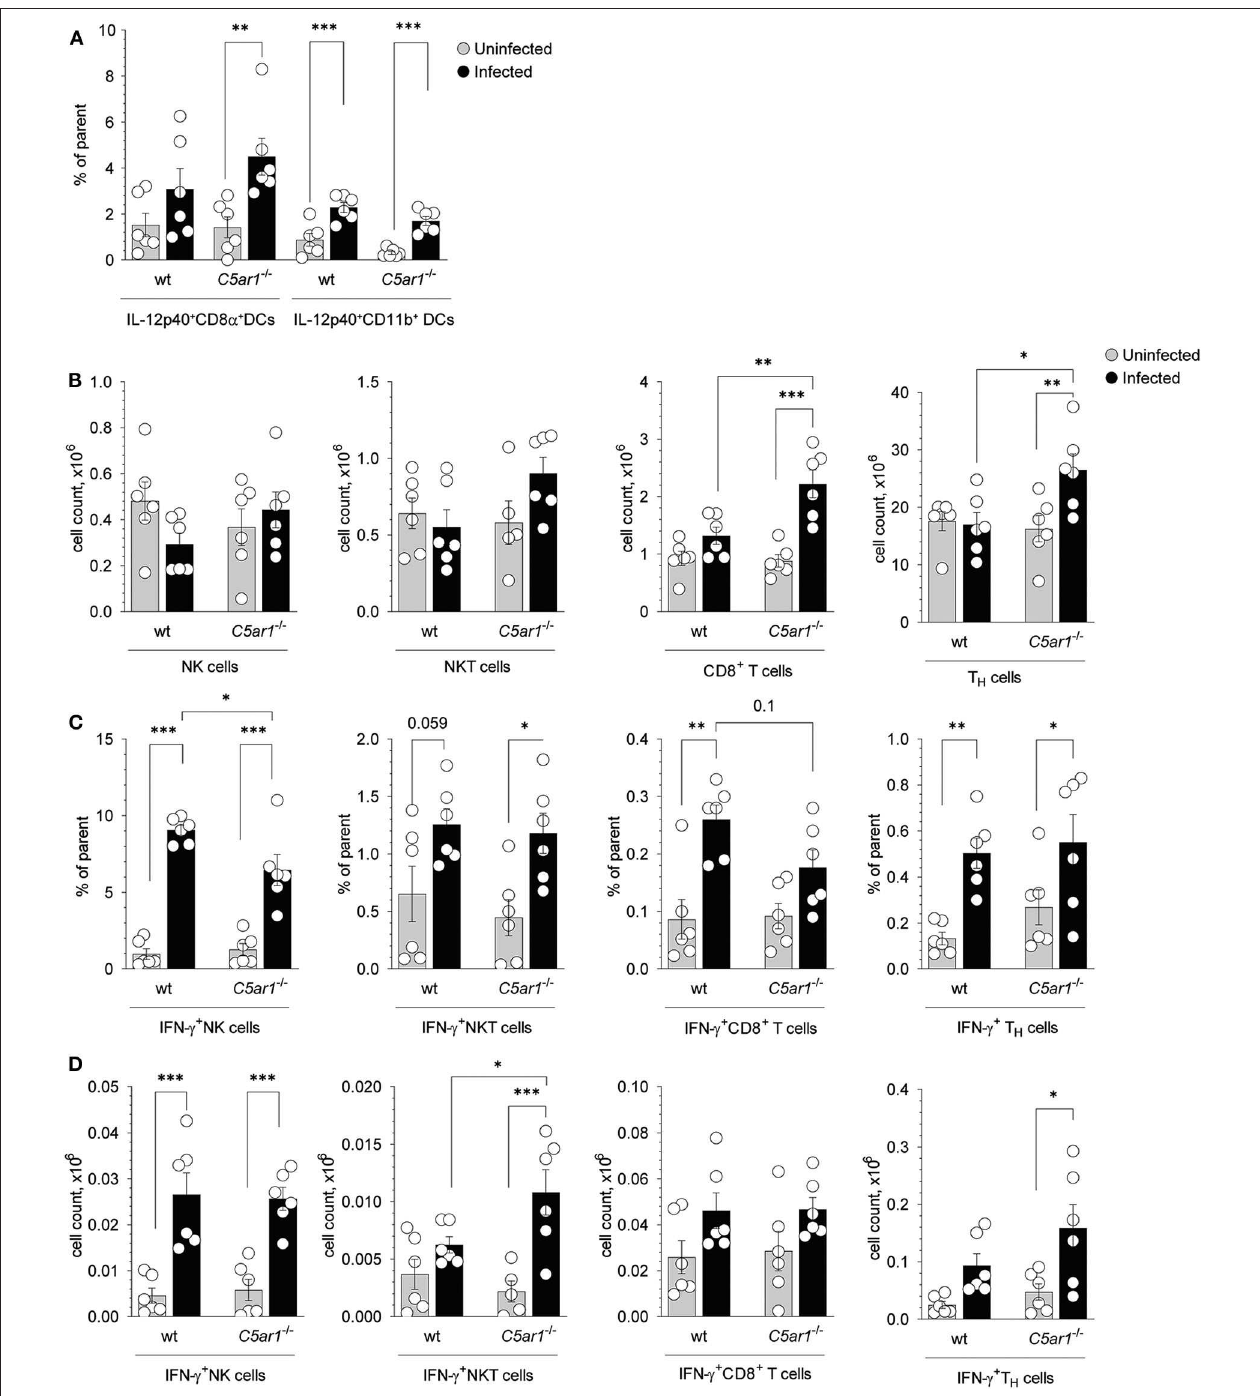
FIGURE 6 | Impact of C5aR1 activation on IL-12p40 production from splenic DCs and IFN- γ production from splenic NK, NKT, and T cells during acute T. gondii infection. (A) Frequencies of IL-12p40 + CD8 α + (left) and IL-12p40 + CD11b + (right) DCs in the spleen of uninfected and T. gondii -infected wt and C5ar1 − / − mice, n = 6/group. (B–D) Total cell numbers (B) , frequencies (C) , and numbers (D) of IFN- γ + NK (left), NKT (middle-left), CD8 + T cells (middle-right), and CD8 − T H cells (right) in the spleen of uninfected and T. gondii infected wt and C5ar1 − / − mice, n = 6/group. Cytokine production was assessed at day 5 after T. gondii infection by the intracellular staining. Cells were incubated ex vivo for 2h in the presence of 3 µ g/ml of Brefeldin A without additional stimulation. Values shown are the mean ± SEM, Differences between groups were determined by ANOVA and Sidak’s post-hoc test, * p < 0.05, ** p < 0.01, *** p < 0.001.